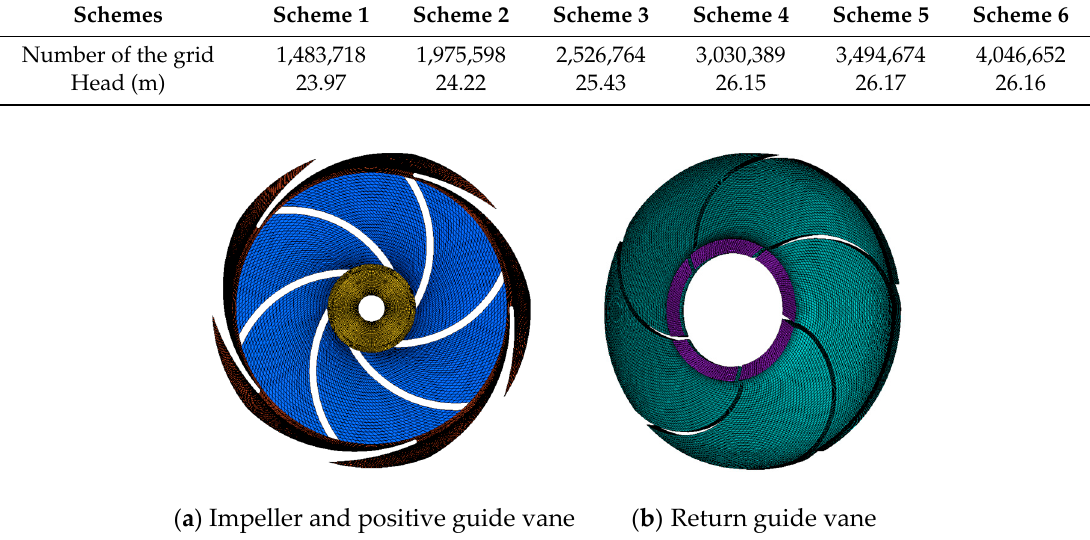
Figure 3. Grid diagram of the impeller and guide vane of the model jet centrifugal pumps (JCP).